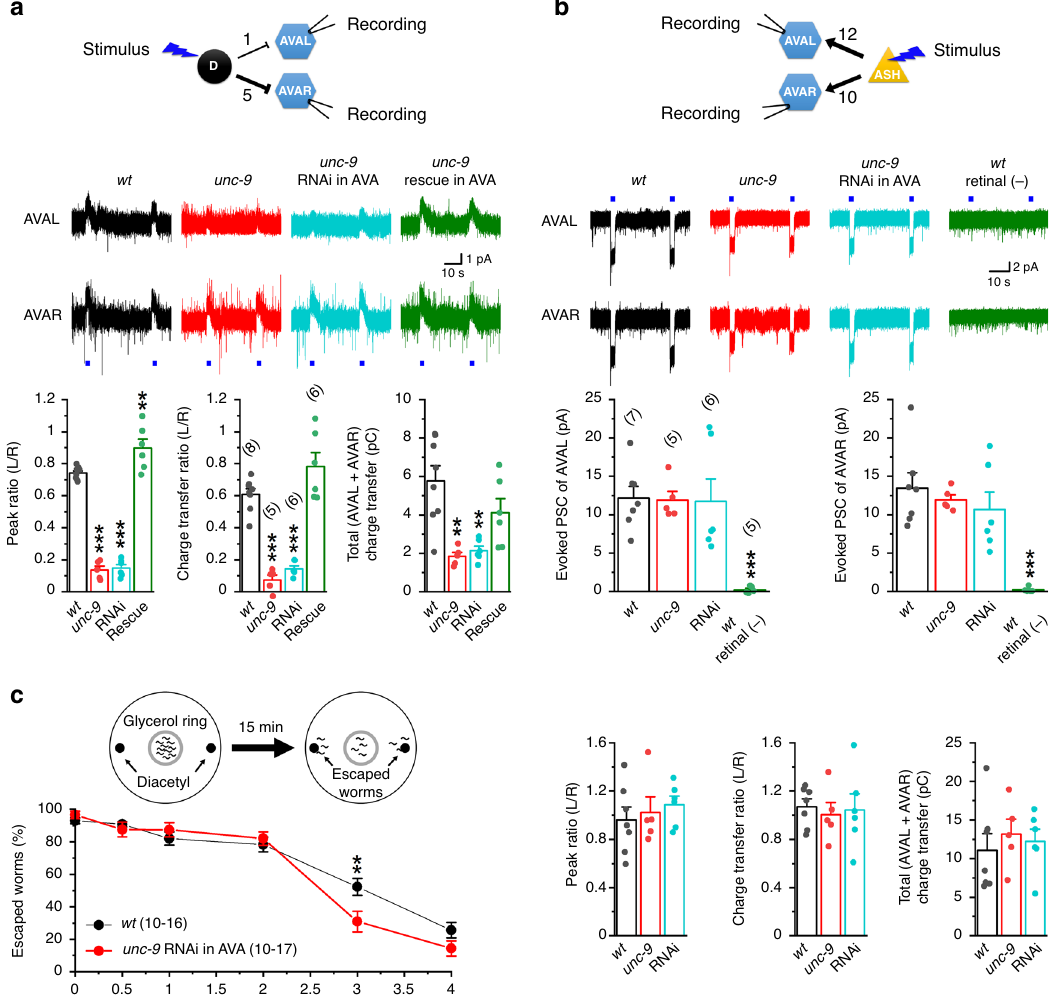
Fig. 9 Gap junctions between AVAL and AVAR help biased threat-reward decision-making by equilibrating inhibitory synaptic inputs from D-MNs. a , b UNC-9 innexin is required for equilibrating inhibitory postsynaptic current (PSC) caused by optogenetic activation of D-MNs but not excitatory PSC caused by optogenetic activation of ASH sensory neurons. Top: diagram indicating the numbers of chemical synapses from D-MNs and AHS neurons to AVAL and AVAR, and the neurons for optogenetic stimulation and PSC recording. Middle: sample current traces. AVA were held at − 10 mV. The blue lines indicate the times of blue light stimulation. Bottom: comparison of the AVAL/AVAR ratios of peak current and charge transfer, and the total charge transfer (AVAL + AVAR). In a , Compared with wild type ( wt ), p values of unc-9(fc16) , unc-9 RNAi in AVA, and unc-9(fc16) rescue in AVA are 0.000, 0.000, and 0.008 for peak ratio, 0.000, 0.000, and 0.073 for charge transfer ratio, and 0.002, 0.002, and 0.247 for total charge transfer. In b , Compared with wt , the respective p values of unc-9(fc16) and unc-9 RNAi in AVA are 1.000 and 0.998 for evoked PSC of AVAL, 0.923 and 0.628 for evoked PSC of AVAR, 0.912 and 0.658 for peak ratio, 0.888 and 0.979 for charge transfer ratio, and 0.740 and 0.901 for total charge transfer. The p values between wt and wt retinal ( − ) were 0.000 for evoked PSC of both AVAL and AVAR. c Disruption of AVAL and AVAR electrical coupling reduced escape probability from a hyperosmotic glycerol barrier in a multisensory behavioral assay, in which 10 – 15 worms were placed inside a glycerol ring (1-cm diameter) on an agar plate (6-cm diameter) with two drops of diacetyl (1:1000 dilution) outside of the ring. The percentage of worms that escaped in 15 min was quanti fi ed. Compared with wt , p = 0.253, 0.466, 0.393, 0.544, 0.010, and 0.117 at glycerol concentrations of 0, 0.5, 1, 2, 3, and 4 M, respectively. The asterisk indicate signi fi cant differences compared with wt (** p < 0.01, *** p < 0.001) based on either one-way ANOVA with Tukey ’ s post hoc test ( a , b ) or unpaired two- sided t -test ( c ). The numbers inside brackets indicate sample size ( n ). n = numbers of independently recorded cells in a and b , but numbers of individual worms in c . In c , sample sizes of the wt and unc-9 RNAi groups varied among different glycerol concentrations. For wt , n = 10, 10, 10, 17, 14, and 11 for the concentrations of 0 – 4 M. For unc-9 RNAi, n = 10, 10, 10, 16, 15, and 16 for the concentrations of 0 – 4 M. Data are presented as mean values ± SEM. Source data are provided as a Source data fi with AVA and AVB, and also interact (either directly or indir- other neurons to control locomotion behavior and threat-reward ectly) with primary sensory neurons 18,19,27 , may modulate decision-making. sensory-motor coupling and multisensory decision-making 17,24 . AVA and RIM may interact with other neurons to generate variable sensory responses 26 . Further studies are needed to innervating ventral or dorsal muscles are controlled by choli- determine whether and how the D-AVA circuit interacts with nergic MNs innervating the contralateral side. This wiring